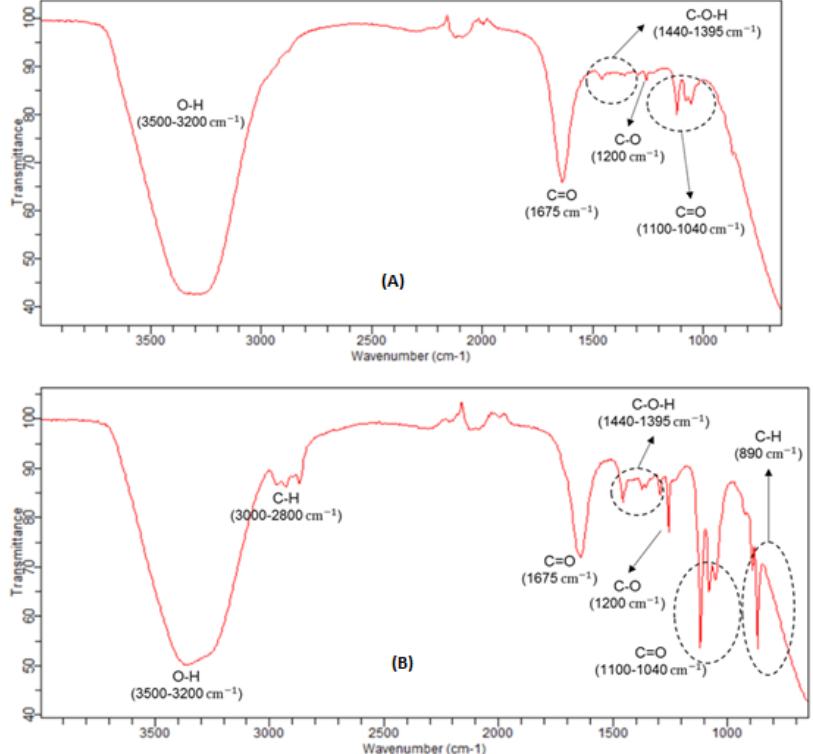
Figure 10. FTIR spectra: ( A ) corresponding to the condensate resulting from the test at 150 ◦ C with 4%g of z. HY catalyst; ( B ) corresponding to the condensate resulting from the test at 300 ◦ C with 2% of z. HY catalyst.